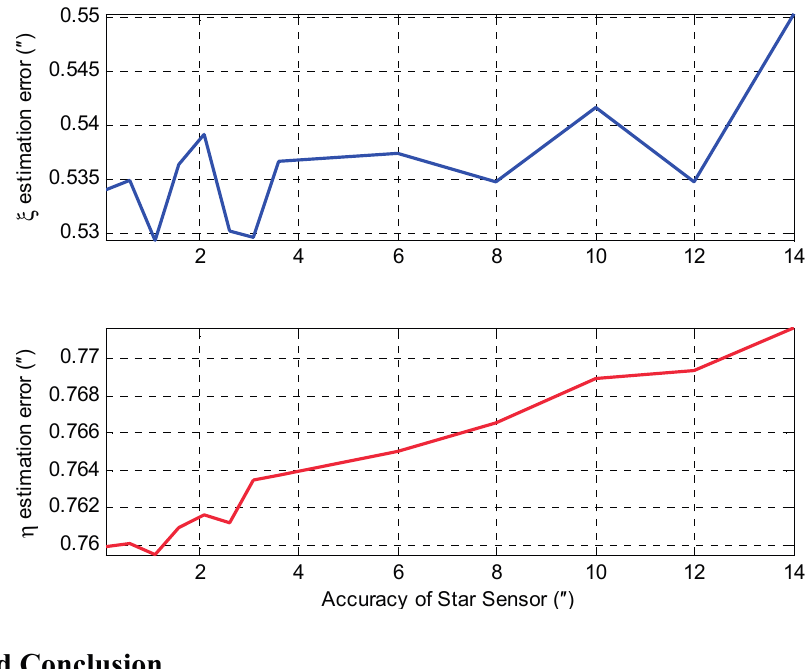
Figure 14. The effect of star sensor accuracy on DOV estimation results after trend error